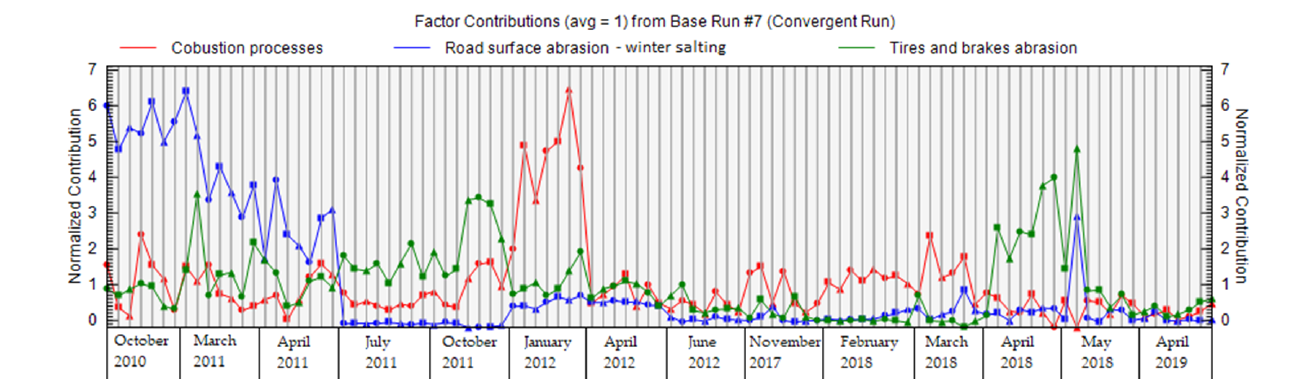
Figure 9. Contribution of factors during individual periods of PM 1 measurements in the city of Žilina.